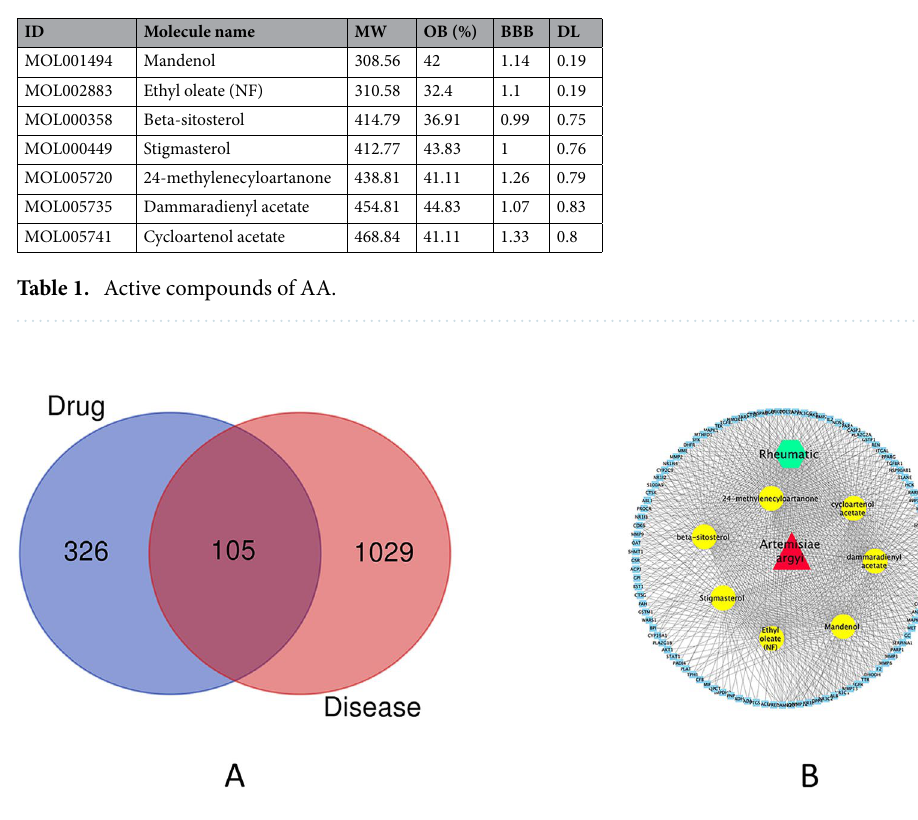
Figure 1. Construction of the compound-disease network. ( A ) Venn diagram of target genes for RA and active compounds. RA has 1134 target genes, whereas active components have 431 target genes. A total of 105 overlapping target genes are found between the two sets, ( B ) Medicine-ingredient-target-disease network with four parts (Red: Artemisia argyi (AA), green: RA, yellow: active ingredients of AA, blue: 105 potential common targets) was generated by Cytoscape (Version, 3.8) (http:// cytos cape.